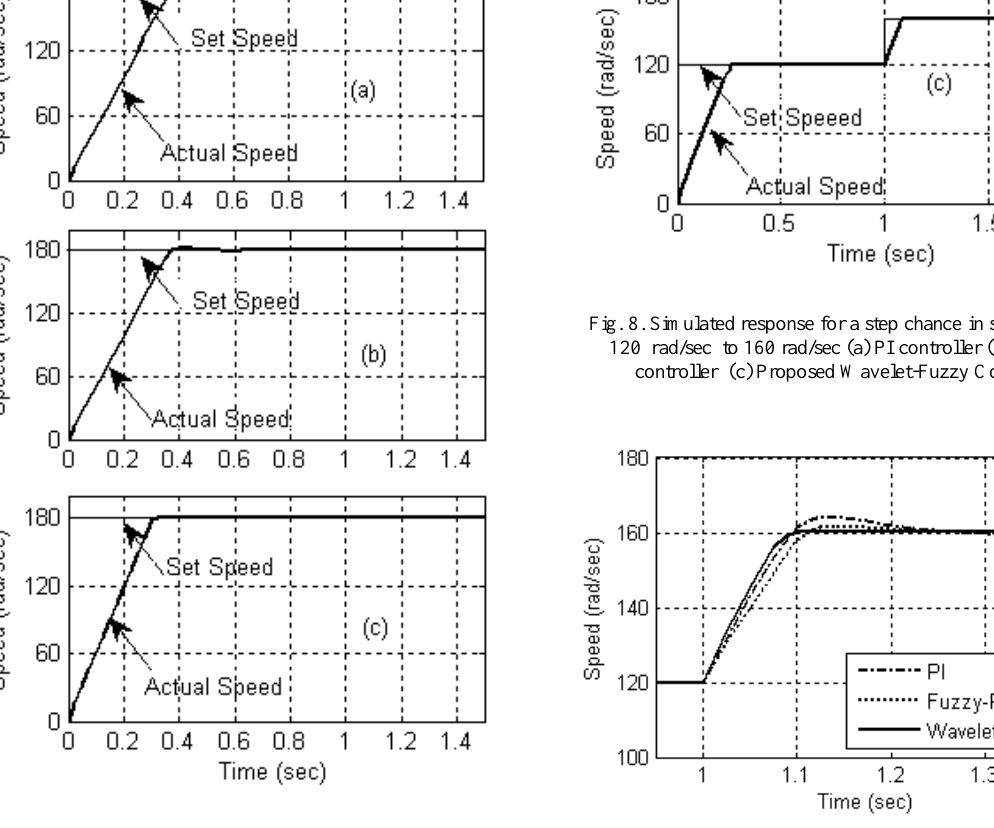
Fig. 9. Comparision of the step change in set speed for PI controller, Fuzzy-PI controller and the Proposed Wavelet- Fuzzy